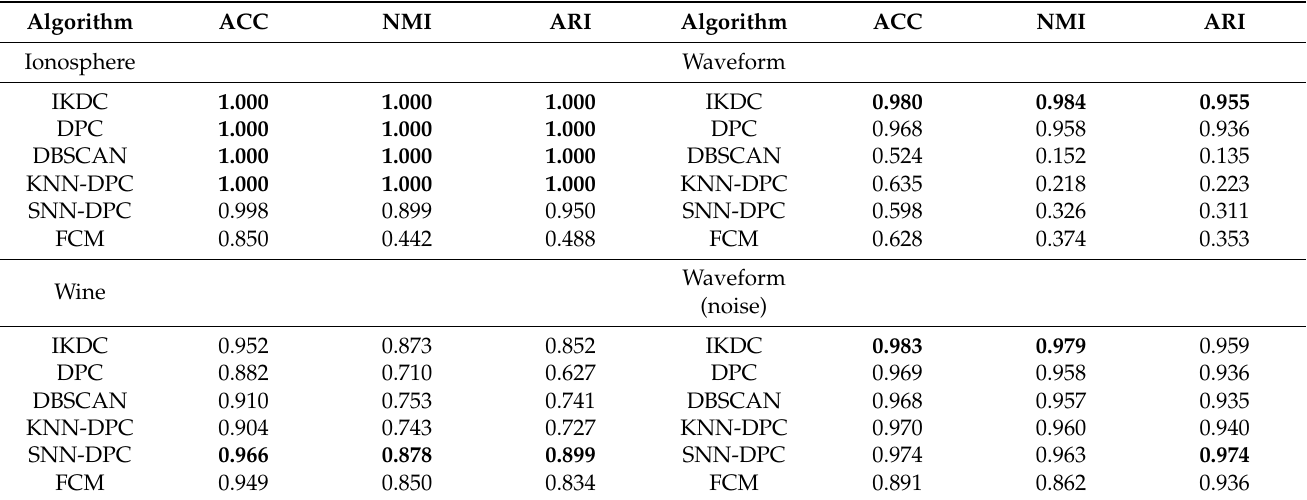
Table 6. ACC, NMI, and ARI of six algorithms on different real datasets.